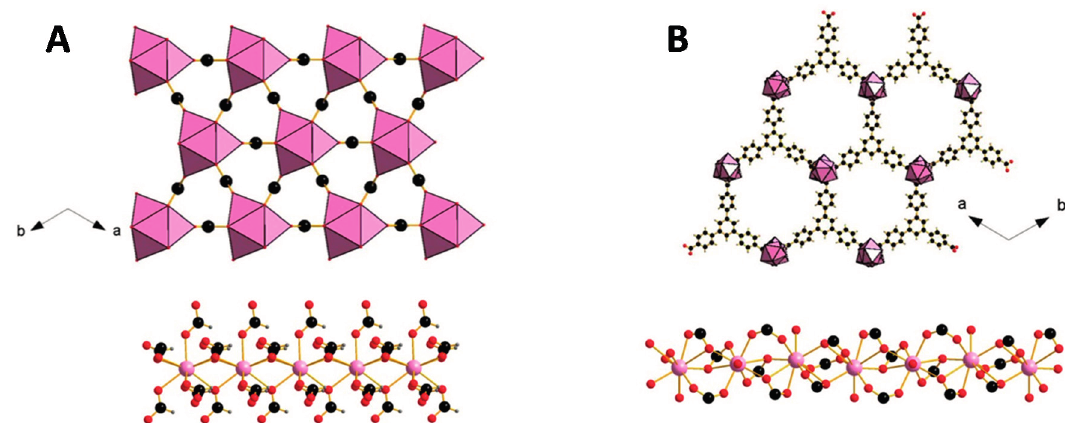
Figure 1. Illustration of the structural organization of Nd(form) 3 ( A ) and MIL-103(Nd) ( B ). Pink for Nd, black for C, red for O, grey for H, a and b: crystallographic axes. Three strategies that are represented in Figure 2 were considered, to have a combination of Nd/Eu(Tb)